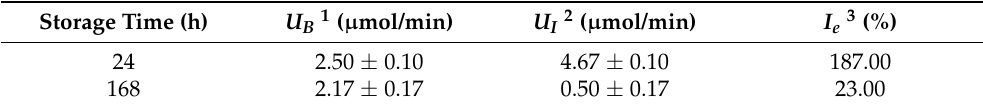
Table 8. Lipolytic activity of immobilized ANL stored under the conditions recommended by ChiralVision (24 h, room temperature) and in a climate chamber (168 h).